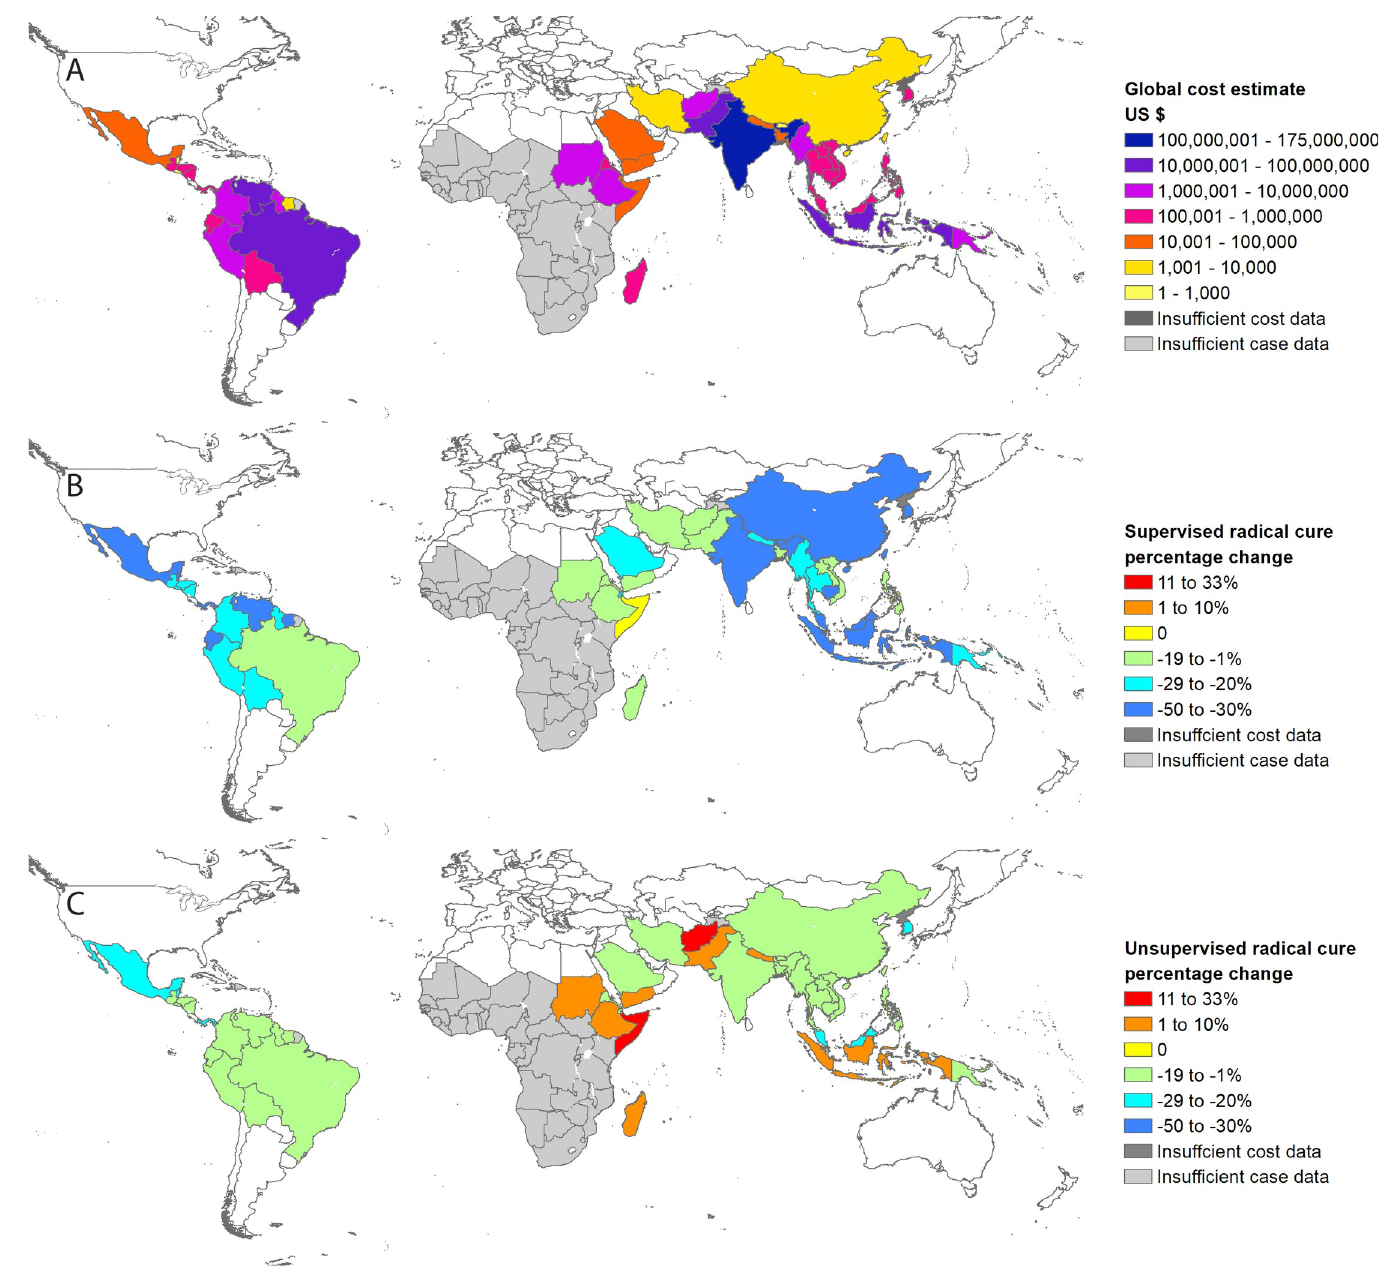
Fig 2. Global map of the economic cost burden due to vivax malaria and potential impact of radical cure. (A) The baseline global costs, (B) the Supervised radical cure scenario, and (C) the Unsupervised radical cure scenario. Percentage change in total costs from the baseline global costs are shown for the radical cure scenarios. Costs are in 2017 United States Dollars. Countries in light grey are thought to have endemic P . vivax but insufficient information to generate case estimates. Countries in dark grey have insufficient cost data. Global national shapefile obtained from the Malaria Atlas Project (MAP; https://malariaatlas.org/) and available for download through the malariaAtlas R